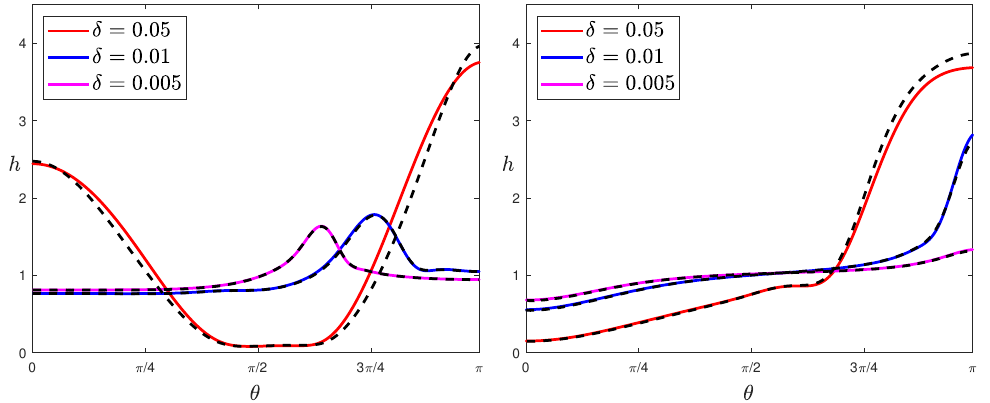
Figure 3. Steady dimensionless thickness profiles at t = 1150 s, for Bo = 0.0057. The solid lines represent the results derived by employing the lubrication model, and the dashed lines represent the solutions of the Navier–Stokes equations. Film parameters: δ = 0.05, δ = 0.01, and δ = 0.005. ( left ) Thickness profiles on an oblate spheroid for γ = 0.5; ( right ) Thickness profiles on a prolate spheroid for γ =